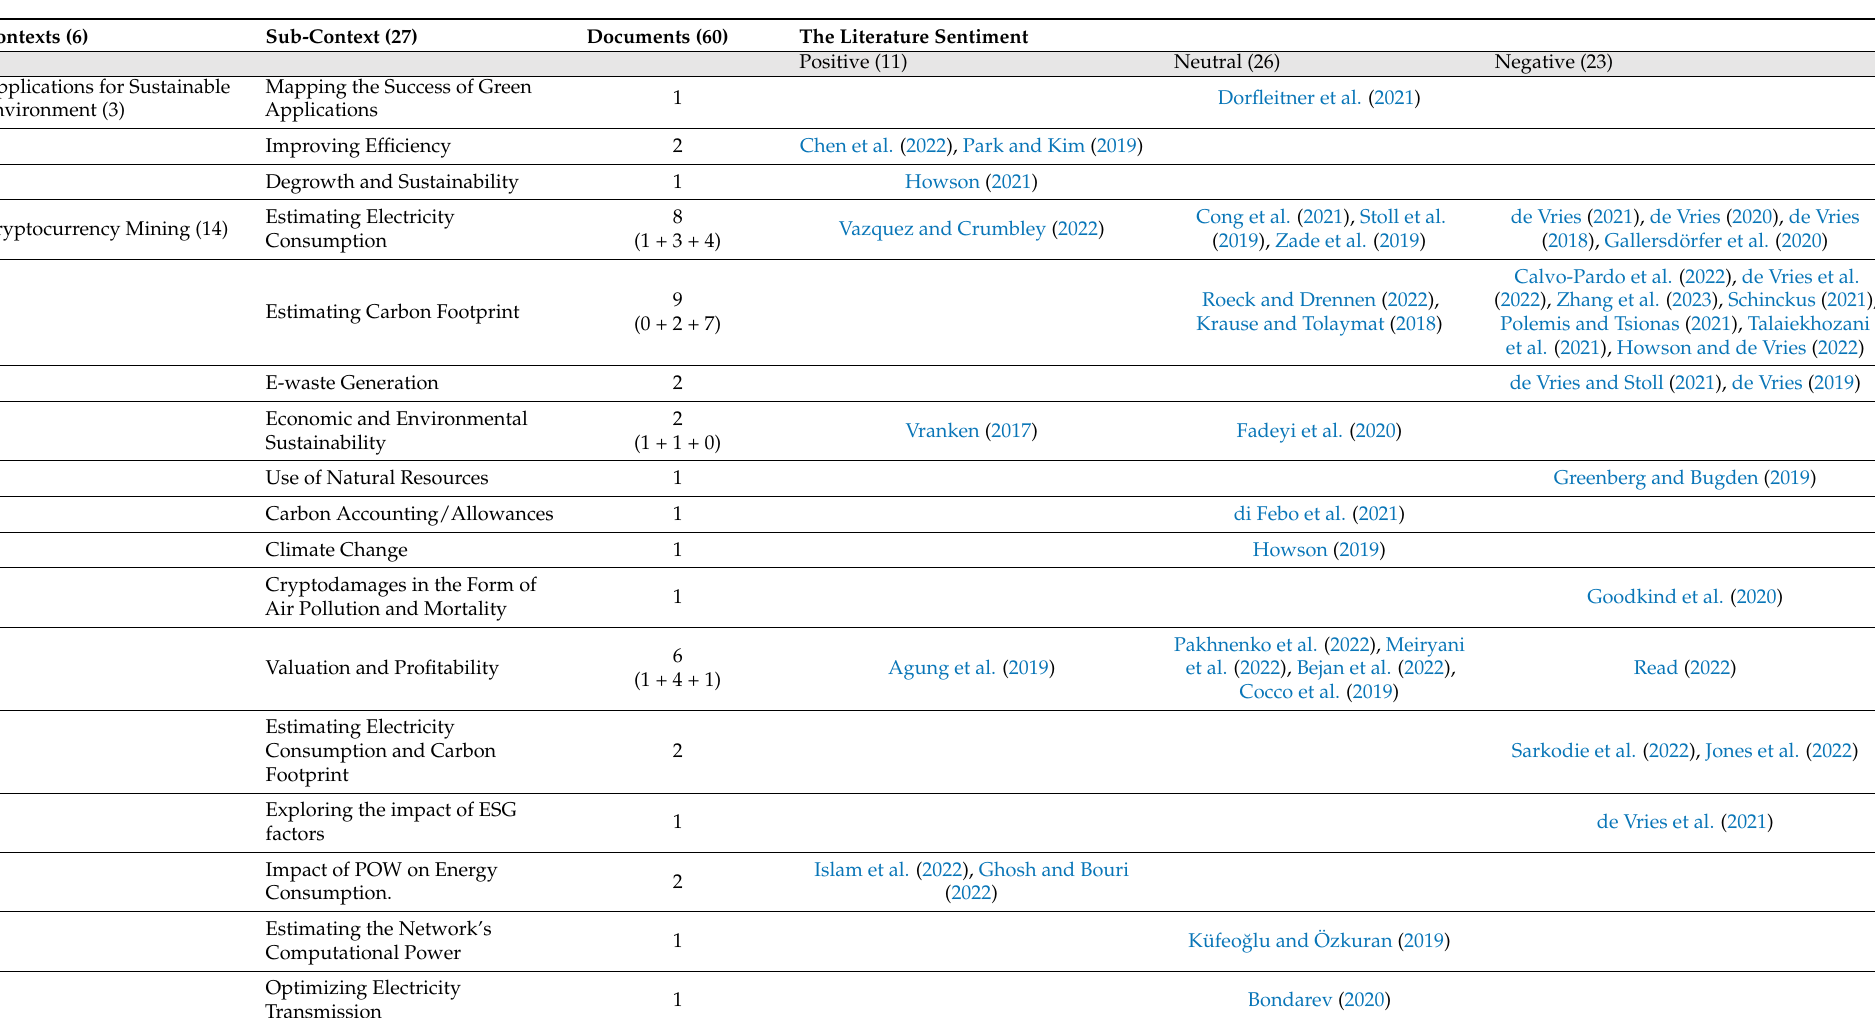
Table 8. Mapping of Context–Sub context and Authors’